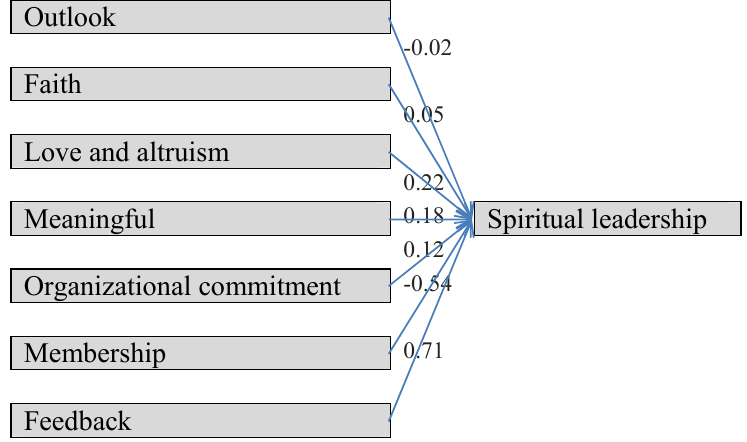
Fig. 2. The results of standard values associated with the implementation of SEM